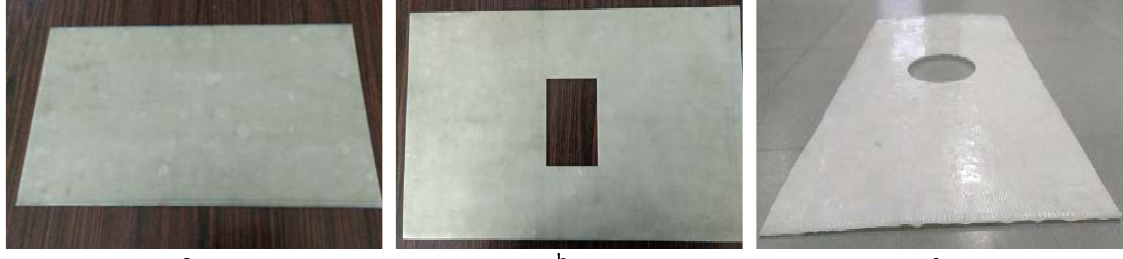
Figure 1:Tthe workpiece (a) bare plate, (b) late with rectangular cutout, and (c) plate with circular cutout After the data acquired it is exported to an FFT analyser and read in frequency domain, which shows amplitude response corresponding to frequency. The amplitude response is as shown in Figure 3 in Hertz. Natural frequencies at various frequencies and intervals of time can be seen in Figure